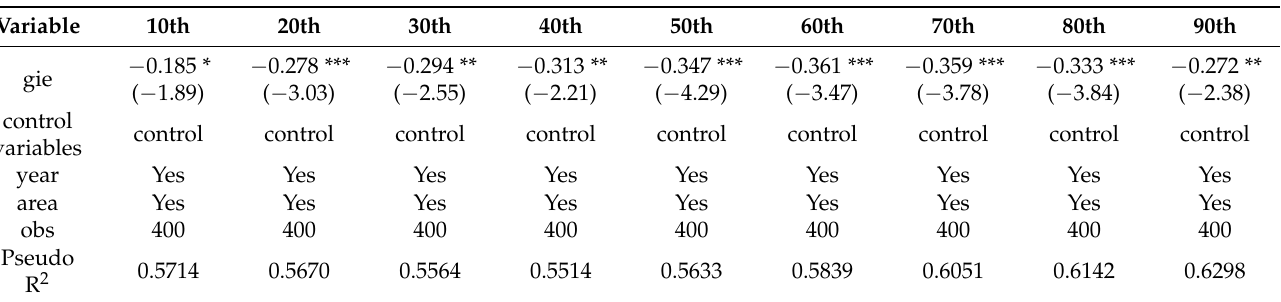
Table 5. Results of panel quantile